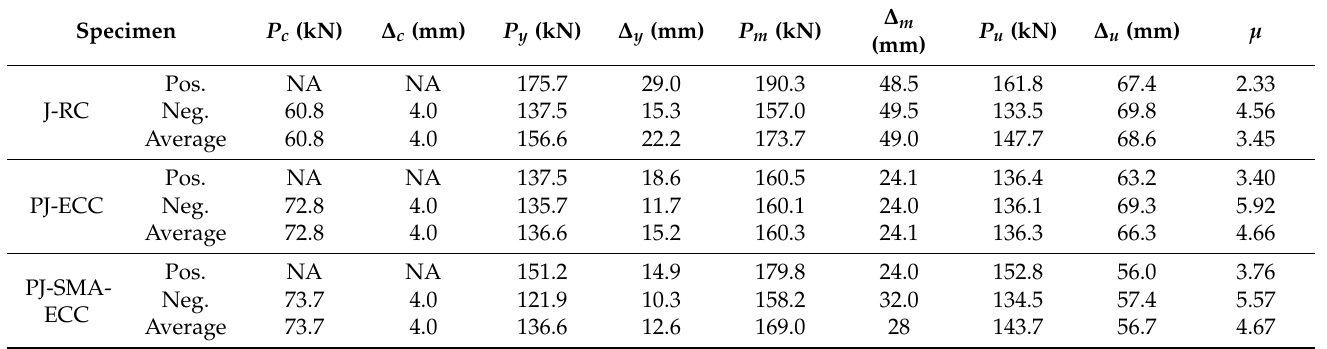
Table 9. Summary of test results for specimens.